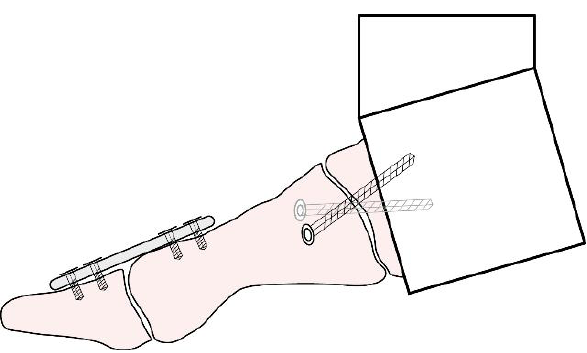
Fig. 1. PS (plate-screw) construct.